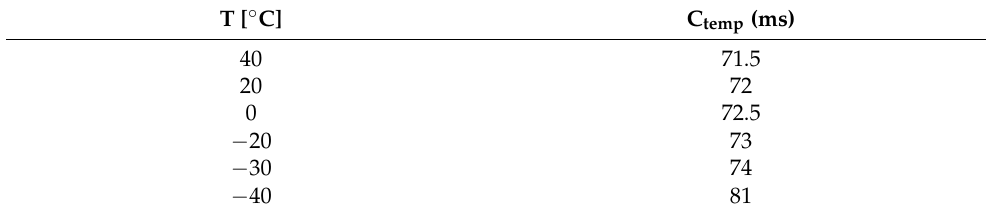
Table 7. Measured values of the dependency of time coefficient on outdoor temperature.